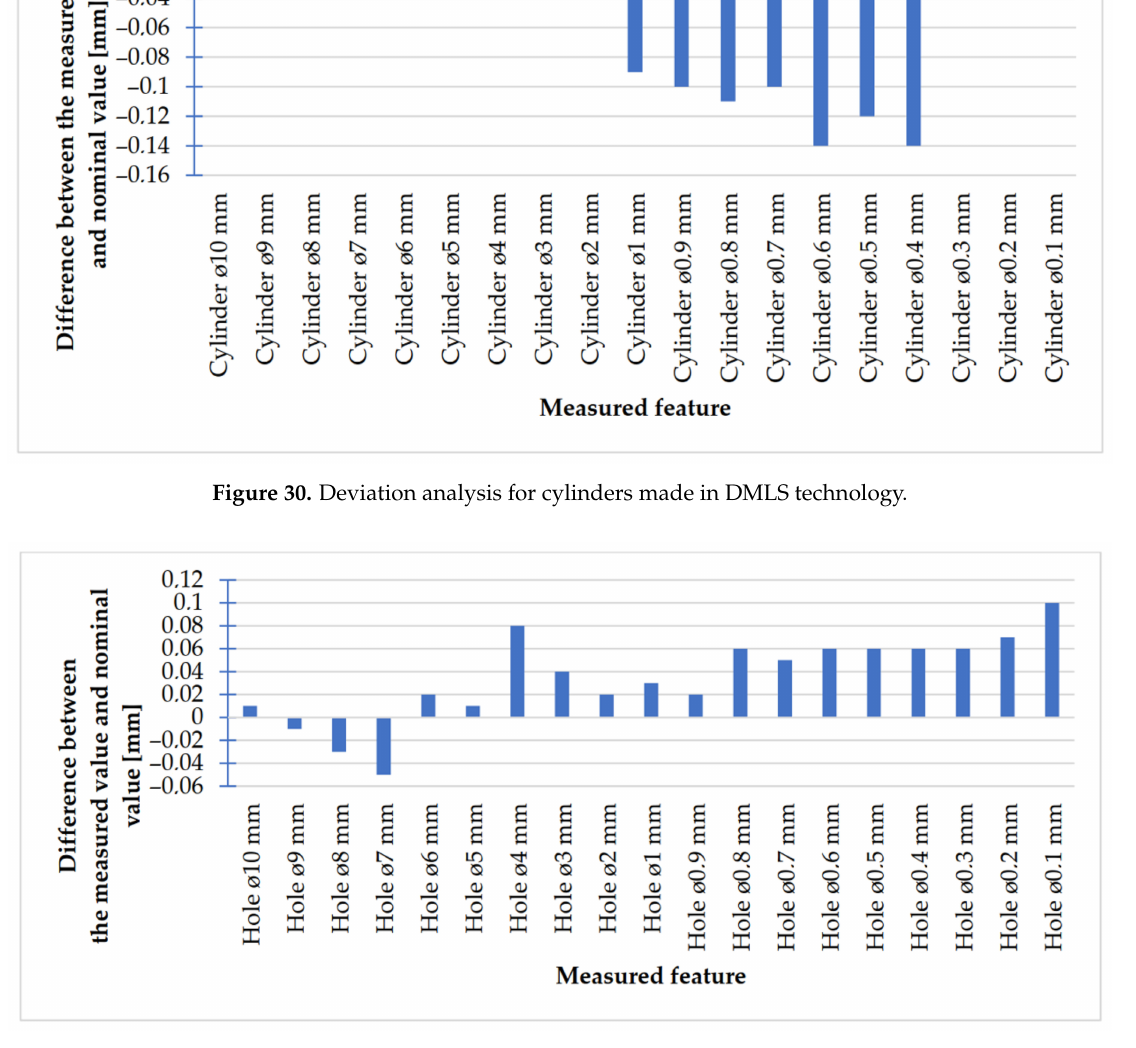
Figure 31. Deviation analysis for cylindrical holes with diameters from Ø10 to Ø0.1 mm of the model made in the DMLS